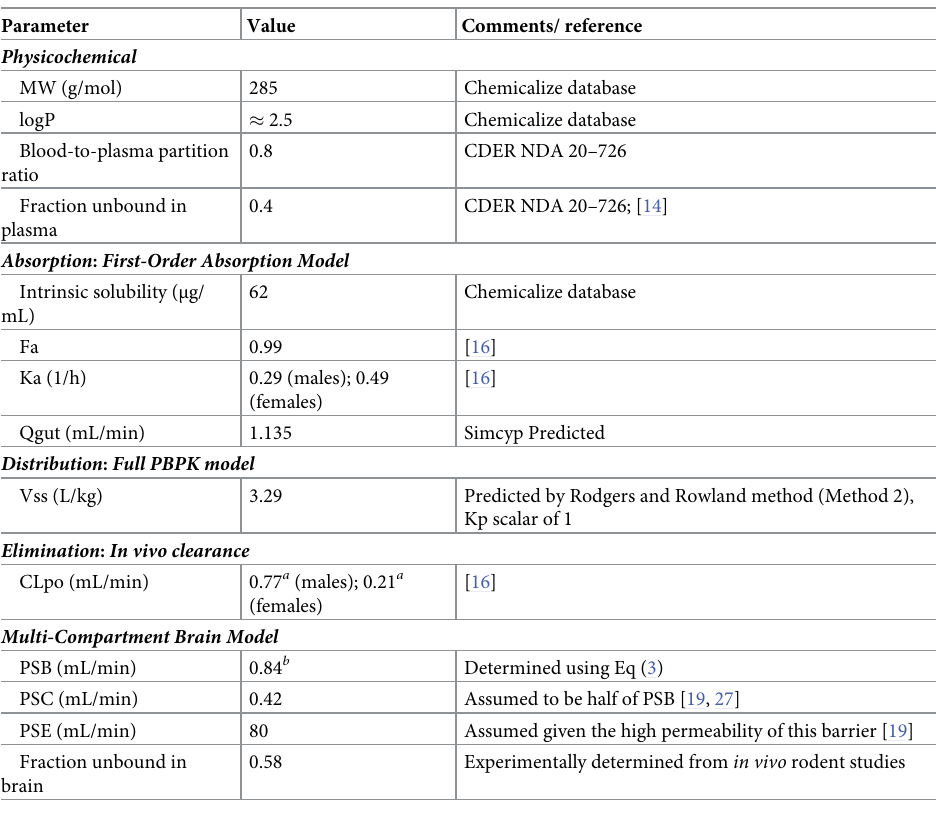
Table 1. Key drug-specific input parameters used for letrozole